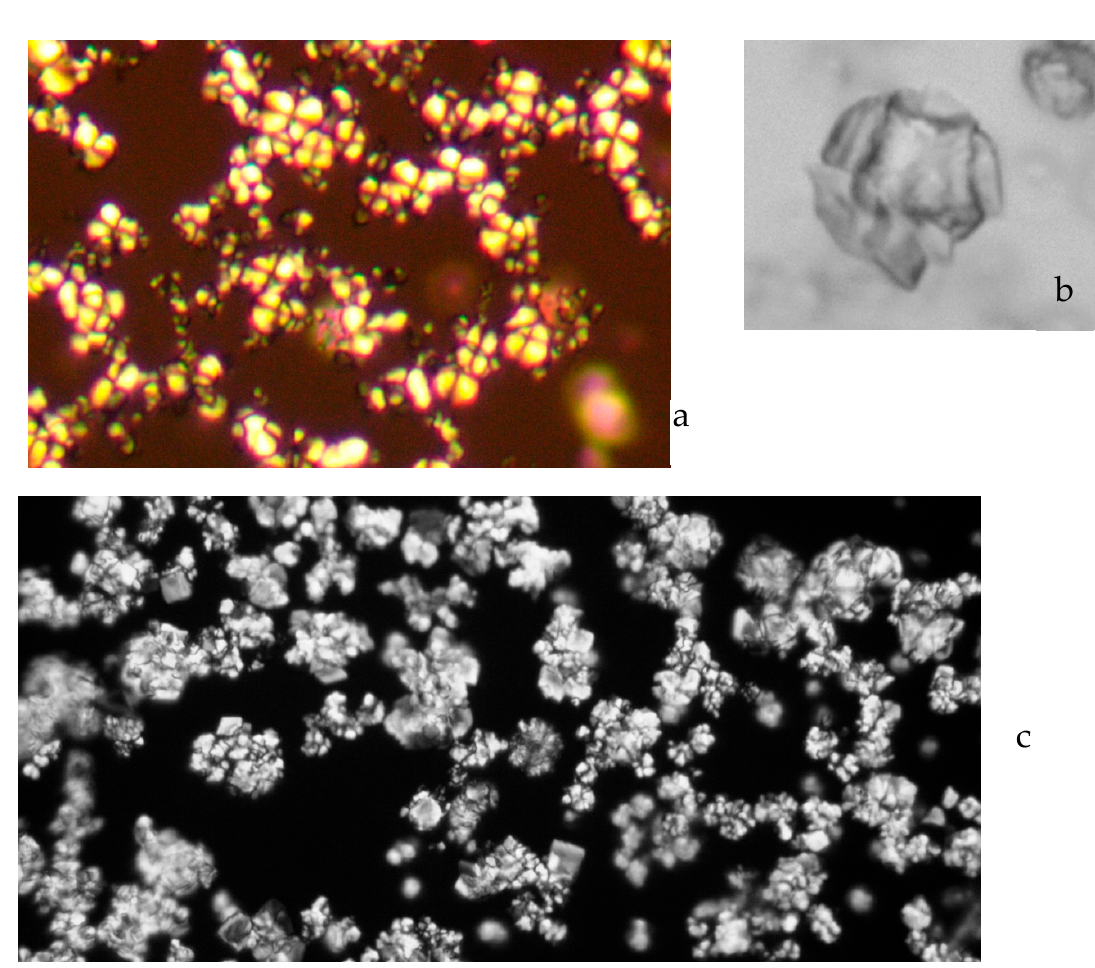
Figure A6. Ca(b)@urea polymer colloids with CaCO 3 or CaSO 4 outer casing. ( a ) Framboidal network. Operating conditions: After 48 h: Feed water salinity = 11.92 g Cl − L − 1 + 5.41 g Na + L − 1 ; Product water salinity = 4.86 g Cl − L − 1 + 4.27 g Na + L − 1 ; Temperature range: 14.5 to 16.9 °C; Circular polarised light. Field of view = 0.1 mm; ( b ) Example polymer framboid. Transmitted light. Field of view = 0.037 mm. ( c ) Framboidal network, operating conditions: After 48 h: Feed water salinity = 3.07 g Cl − L − 1 + 1.41 g Na + L − 1 ; Product water salinity = 1.5 g Cl − L − 1 + 1.13 g Na + L − 1 ; Temperature range: 13.7 to 16.2 °C; Transmitted light. Field of view = 0.25 mm.